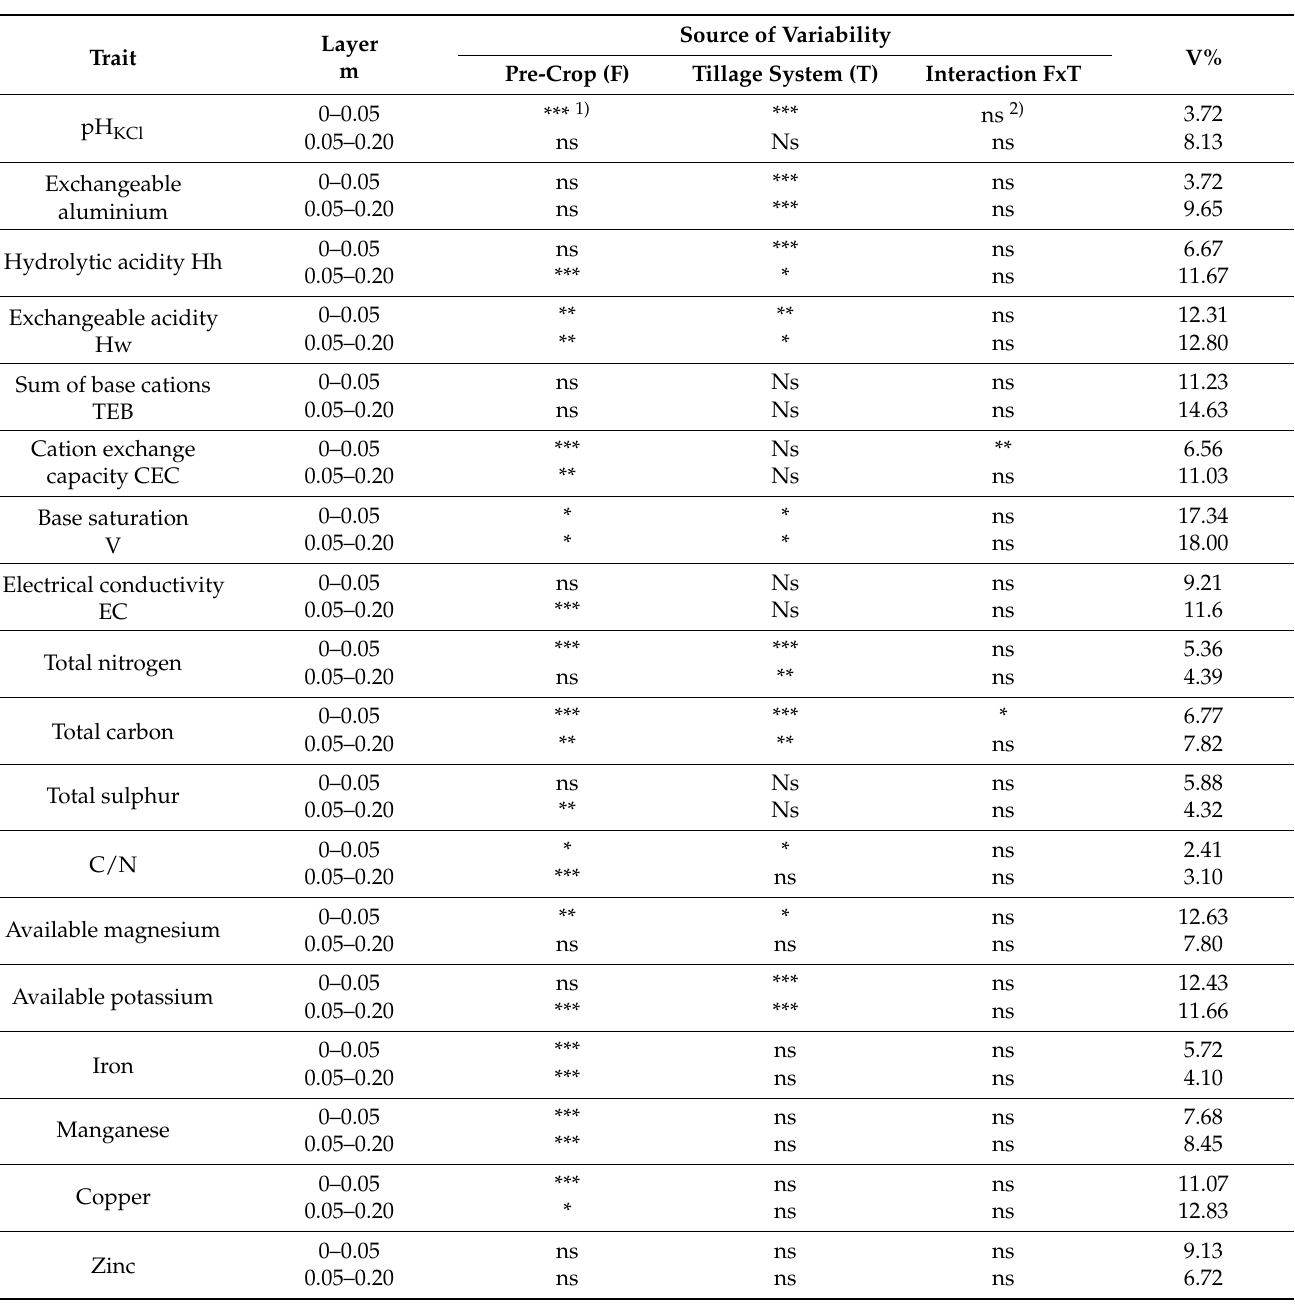
Table 1. Significance of source of variability and V% for estimated soil